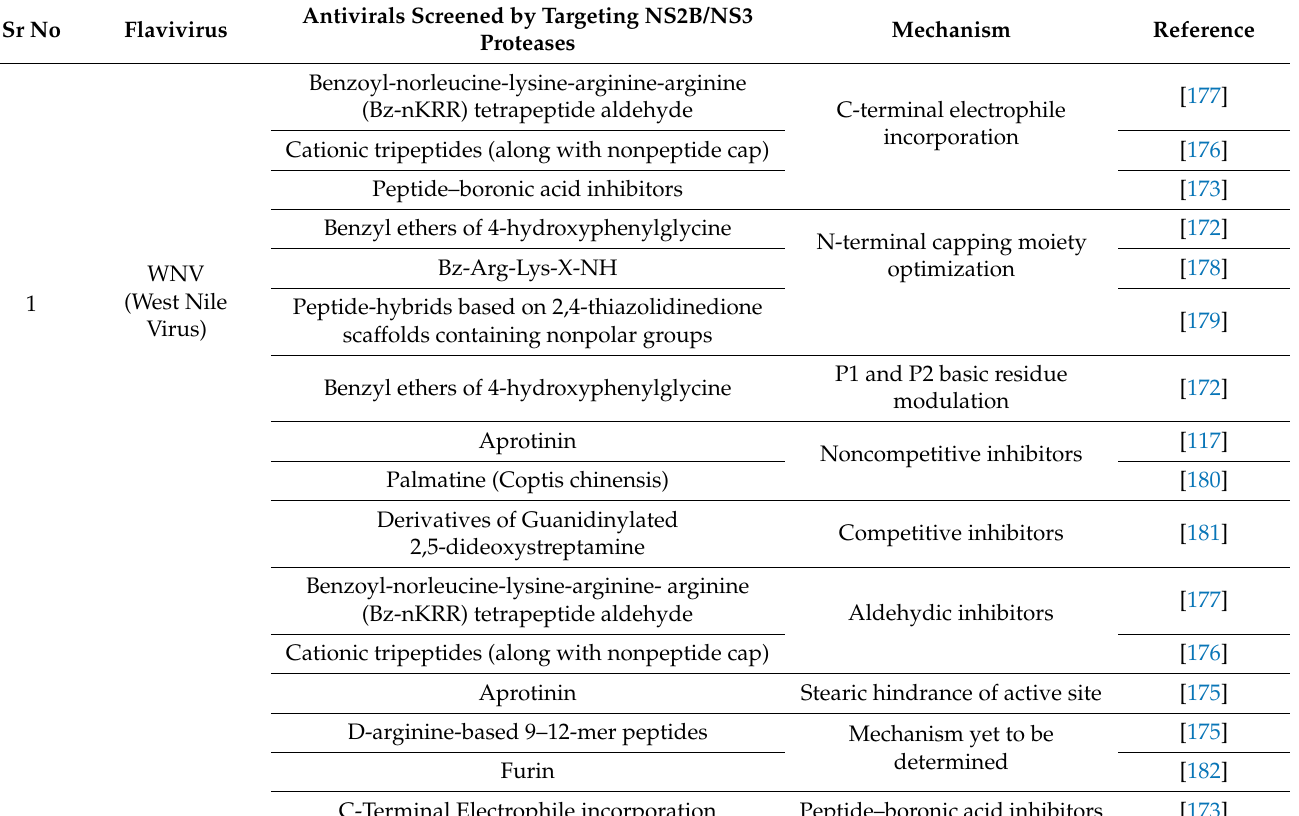
Table 3. Antivirals and their mechanisms screened by targeting flavivirus two-component NS2B- NS3